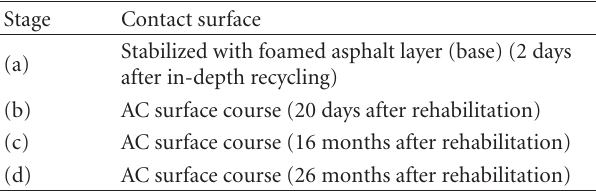
Table 2: Measurements